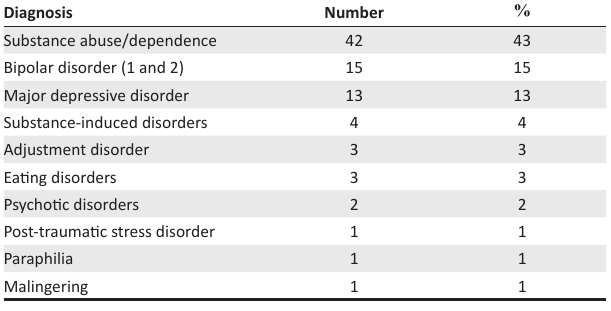
FIGURE 2: Multiple reasons for admission of patients with borderline personality disorder admitted to the acute psychiatric unit at Helen Joseph Hospital during 2010. TABLE 3: Co-morbidities of patients with borderline personality disorder admitted to the acute psychiatric unit at Helen Joseph Hospital during 2010.